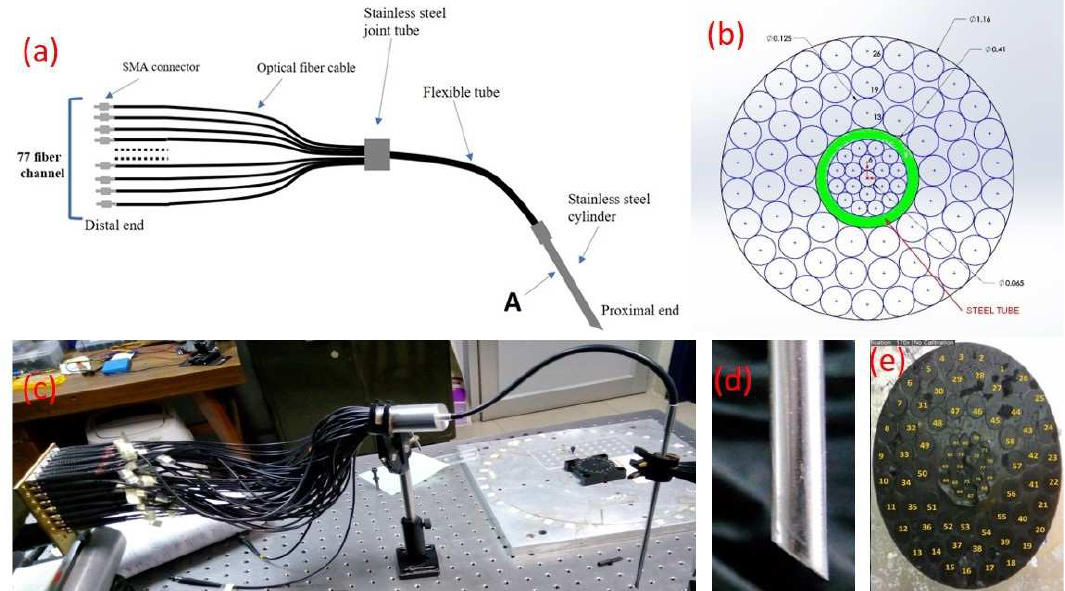
Figure 5. ( a ) Schematic diagram of designed probe, ( b ) perpendicular cross section of probe near proximal end as per the proposed design, ( c ) fabricated prototype of the probe, ( d ) beveled tip of